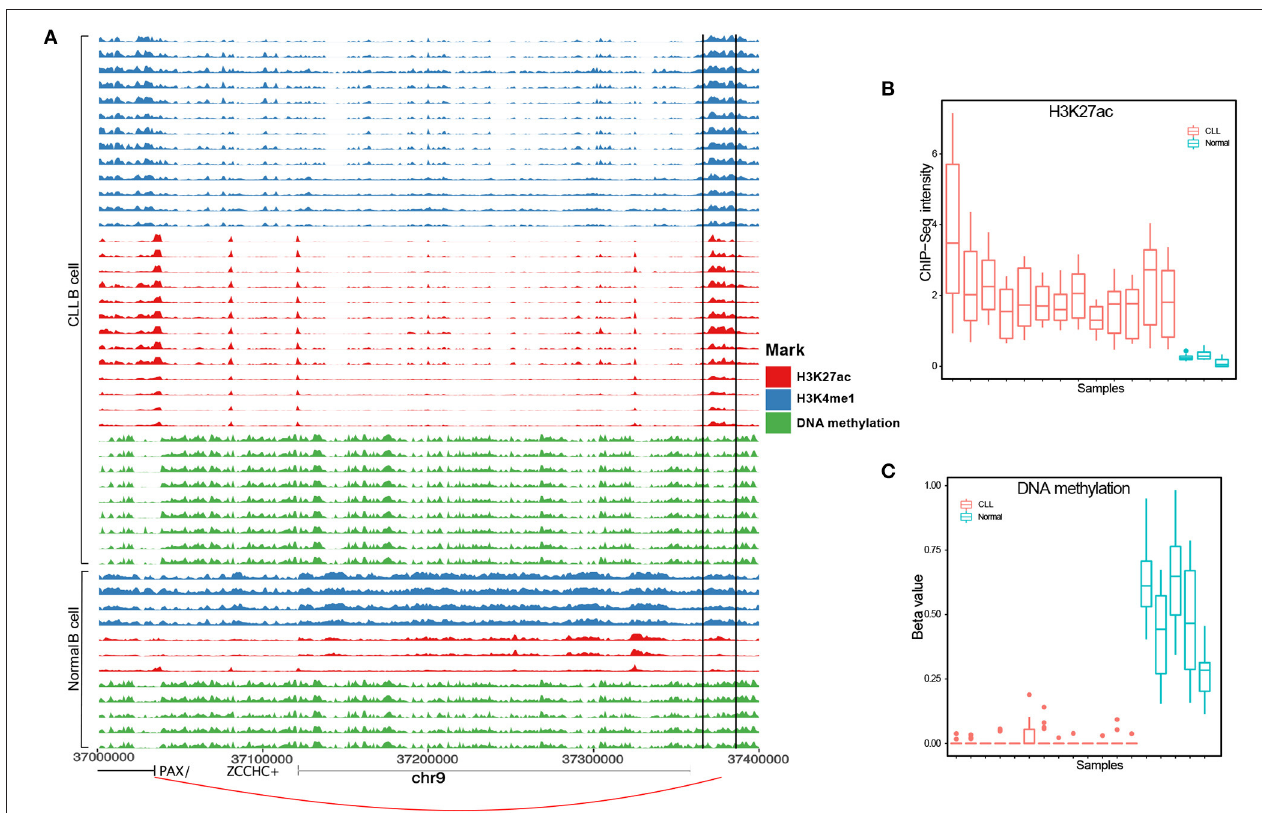
FIGURE 6 | A known PAX5 enhancer (chr9:37,370,916-37,371, and 635) in CLL exhibits hyperacetylation and hypomethylation [analysis of variance (ANOVA) p -value <0.05]. (A) PAX5 enhancer positions in each track are surrounded by two black solid lines. (B) H3K27ac and (C) DNA methylation levels between CLL and healthy